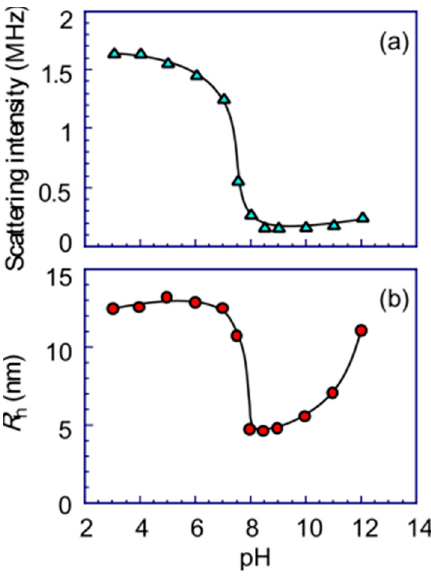
Figure 3. ( a ) Scattering intensity and ( b ) hydrodynamic radius ( R h ) for PAMPS–PAaU as a function of solution pH at C p = 10 g/L in 0.1 M NaCl aqueous solutions.